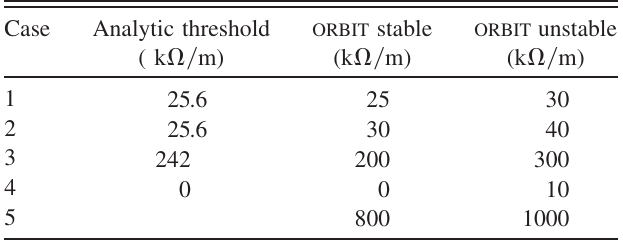
TABLE II. SNS coasting beam stability results: N ¼ 3 : 75 (cid:2) 10 14 protons , n ¼ 10 . Case